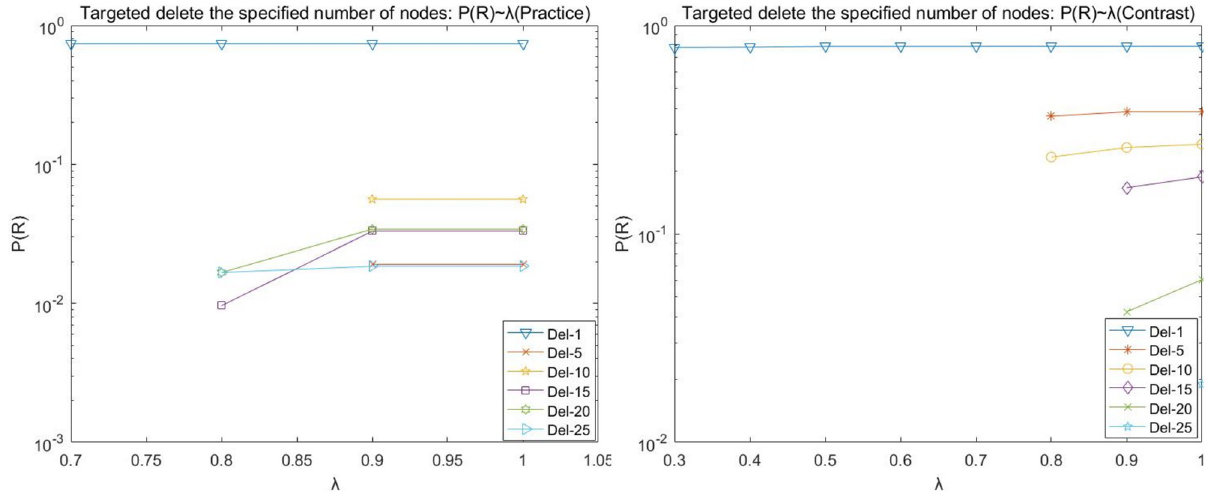
Fig 9. Target disruption- P ( R ) with λ variation